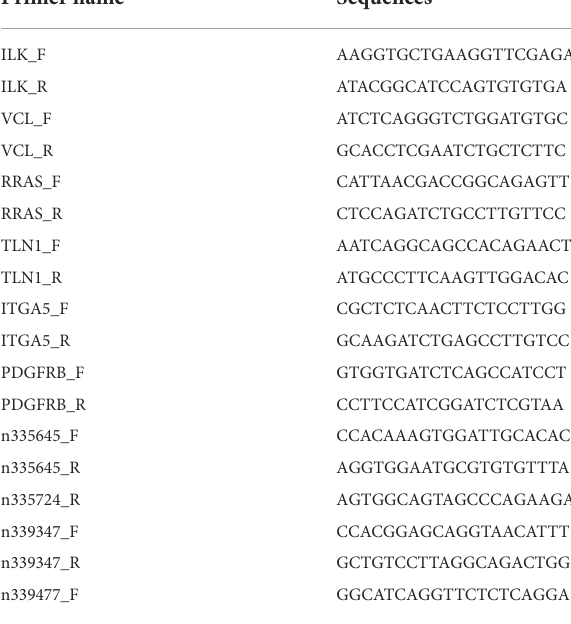
TABLE 3 Primers used for